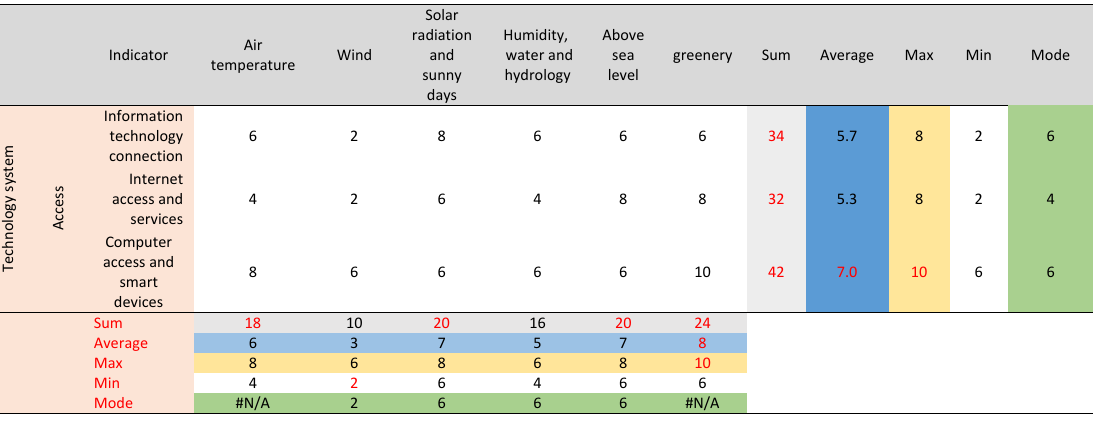
Table 10: Relation between technological system and climate indicators